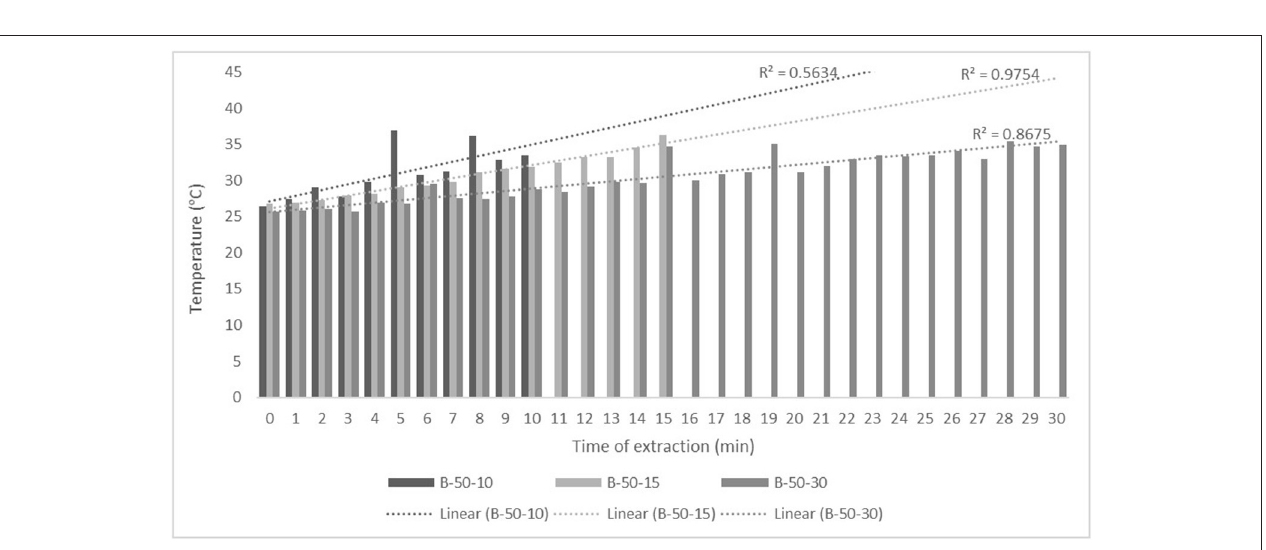
FIGURE 3 | Temperature ( ◦ C) of nettle extracts with 50% v/v ethanol during the UAE in the ultrasonic bath for 10min (B-50-10), 15min (B-50-15), and 30min